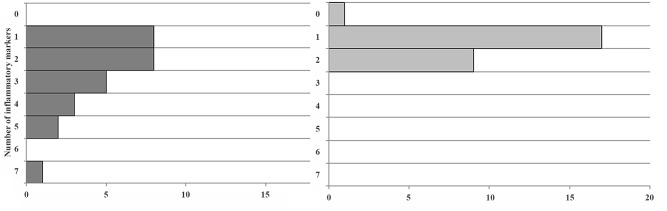
Frequency of concurrently elevated inflammatory biomarkers in the same HD and PD patients.